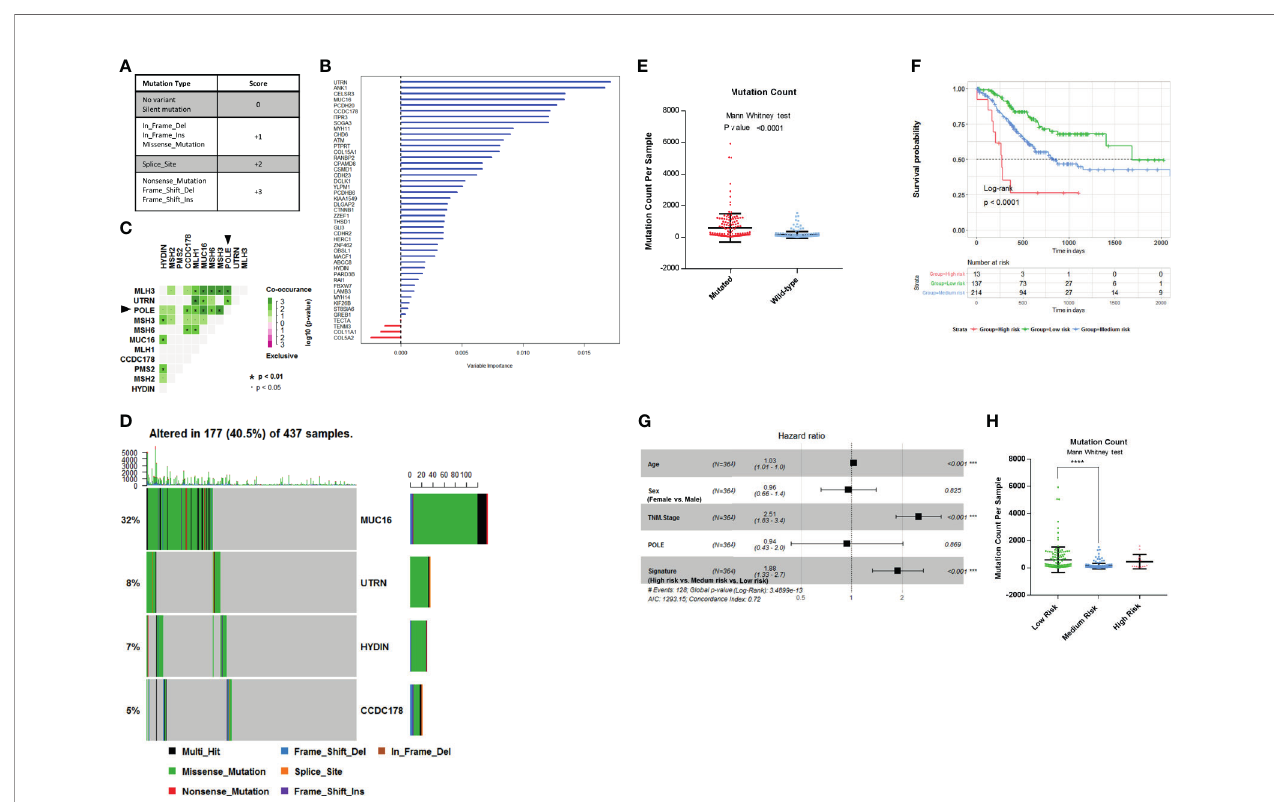
FIGURE 3 | Establishment of survival-related risk score in The Cancer Genome Atlas (TCGA) Stomach Adenocarcinoma (STAD) cohort. (A) Mutation score matrix. (B) Variable importance of the 45 survival-related mutated genes. (C) Mutually exclusive and co-occurring gene pairs in STAD displayed as a triangular matrix. Green indicates tendency toward co-occurrence, whereas pink indicates tendency toward exclusiveness. (D) Mutation count per sample in non-synonymous mutations. Frequency of MUC16, UTRN, HYDIN, and coiled-coil domain-containing protein 178 (CCDC178) mutations and gene mutation patterns. (E) Mutation count per sample of gastric adenocarcinoma strati fi ed by four-gene mutation status. (F) Kaplan – Meier survival analysis strati fi ed by risk score. (G) Multivariable Cox regression model tests for age, sex, TNM stage, polymerase ϵ (POLE) mutation status, and 4-gene mutation score. ***p < 0.001. (H) Mutation count per sample of gastric adenocarcinoma strati fi ed by risk score. ****p < 0.0001 determined by Mann Whitney